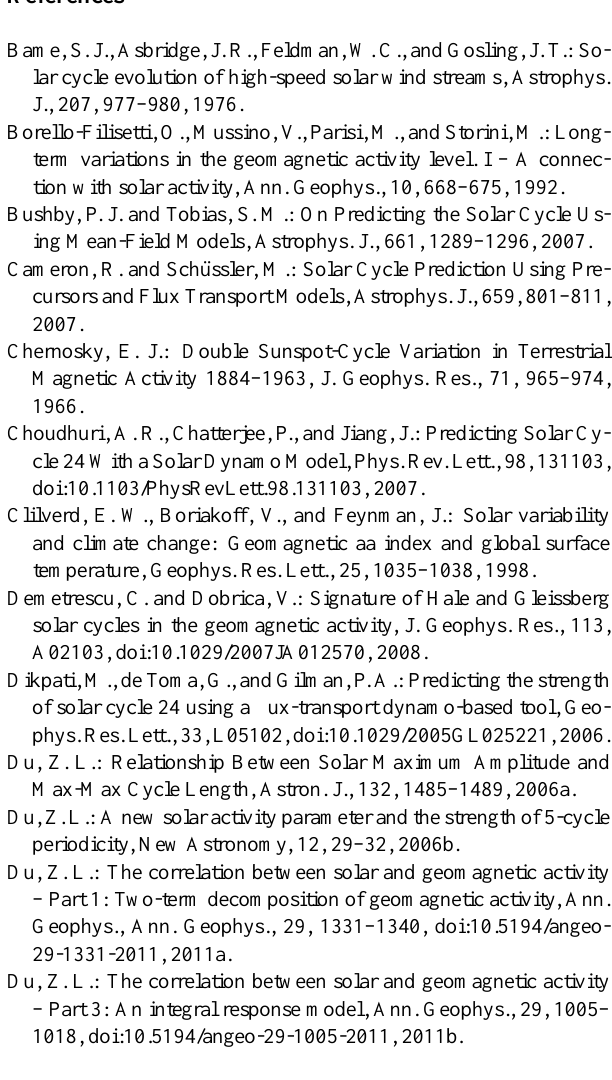
Fig. 2, and the fitting correlation coefficients ( r f = 0 . 91